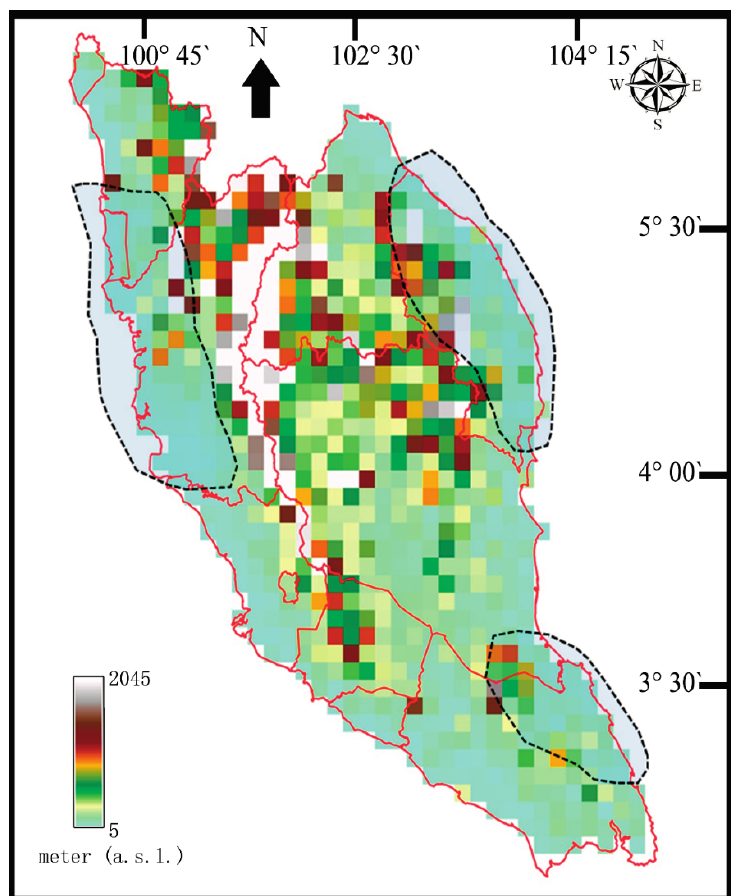
Figure 10. Areas experiencing consistent TRMM underestimations (dashed polygons). The elevation map is derived from re-gridded Shuttle Radar Topography Mission (SRTM) data at 0.125 degree resolution.